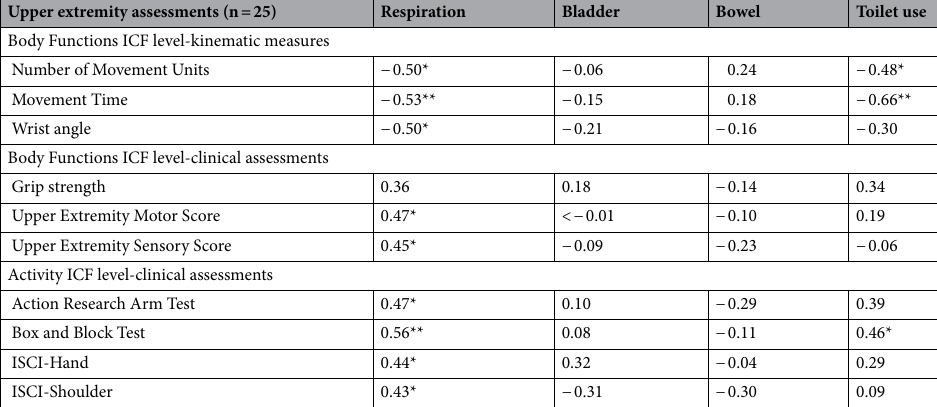
Upper extremity assessments (n =